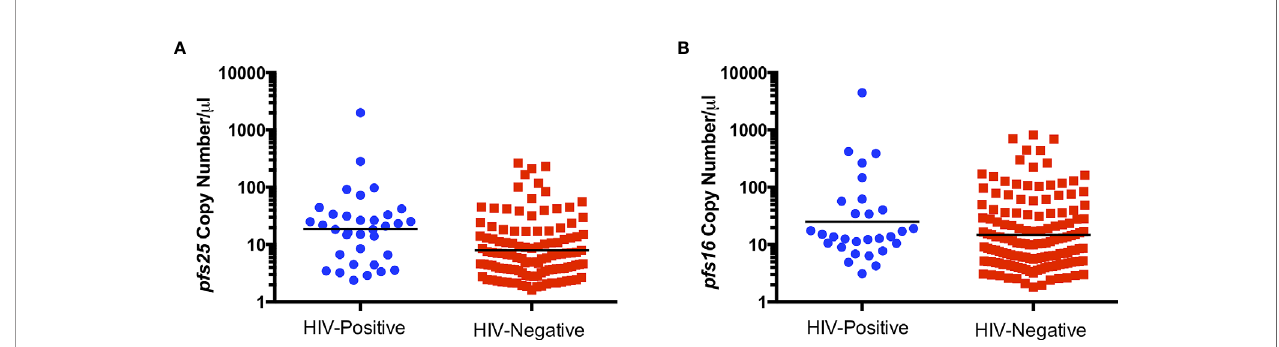
FIGURE 1 | Comparison of pfs25 (A) and pfs16 (B) transcript copy number per µl by HIV status for combined genders and age groups. Black lines indicate geometric means. Transcript copy numbers per µl were signi fi cantly different between groups by Mann-Whitney test ( pfs25 : P=0.0006, pfs16